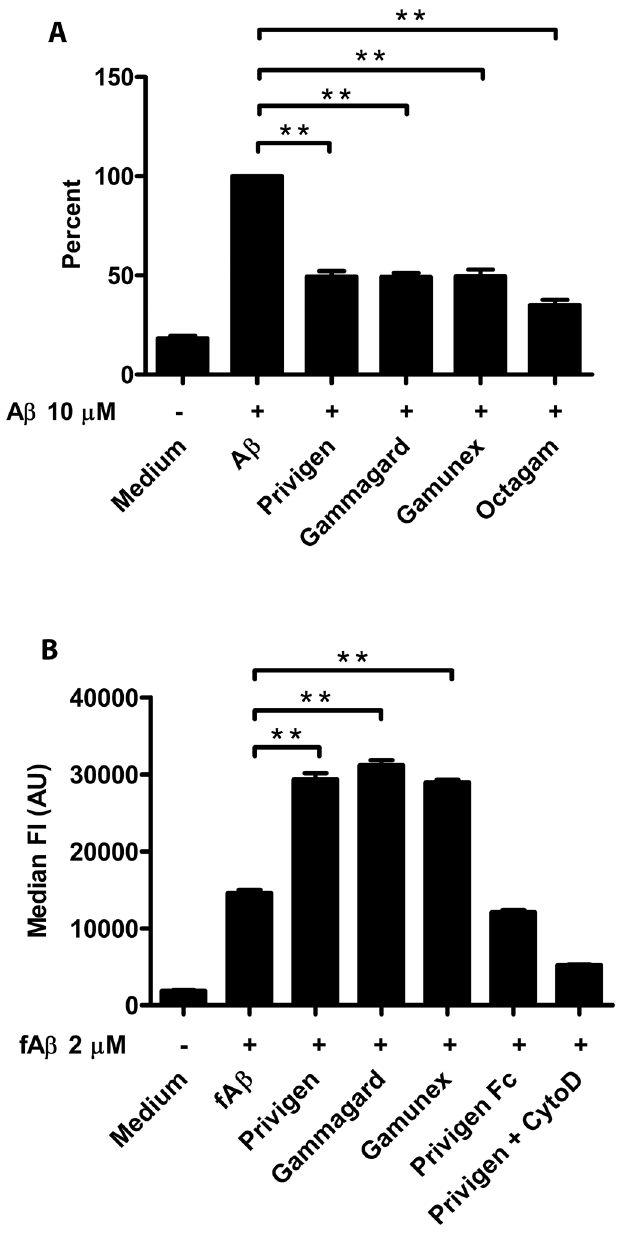
Fig 4. In vitro Comparison of commercial IgG preparations activity in toxicity and phagocytosis assay. (A)SH-SY5Y neuroblastoma cells were treated with 10 μ M monomeric A β 42 alone or co-incubated with 100 μ M Privigen, Gammagard, Gamunex or Octagam for 72h. Neurotoxicity was determined by LDH assay ( ** p < 0.005). (B) For phagocytosis assay, BV ‐ 2 cells were treated with 2 μ M FITC ‐ labeled A β fibrils alone or co ‐ incubated with Privigen, Gammagard, Gamunex and Privigen Fc at 45 μ M, or Privigen 45 μ M + Cytochalasin D ( ** p < 0.005). Privigen Fc fragments and Privigen 45 μ M + Cytochalasin D were used as negative controls. The panel shows combined results from repeated measurements (n =